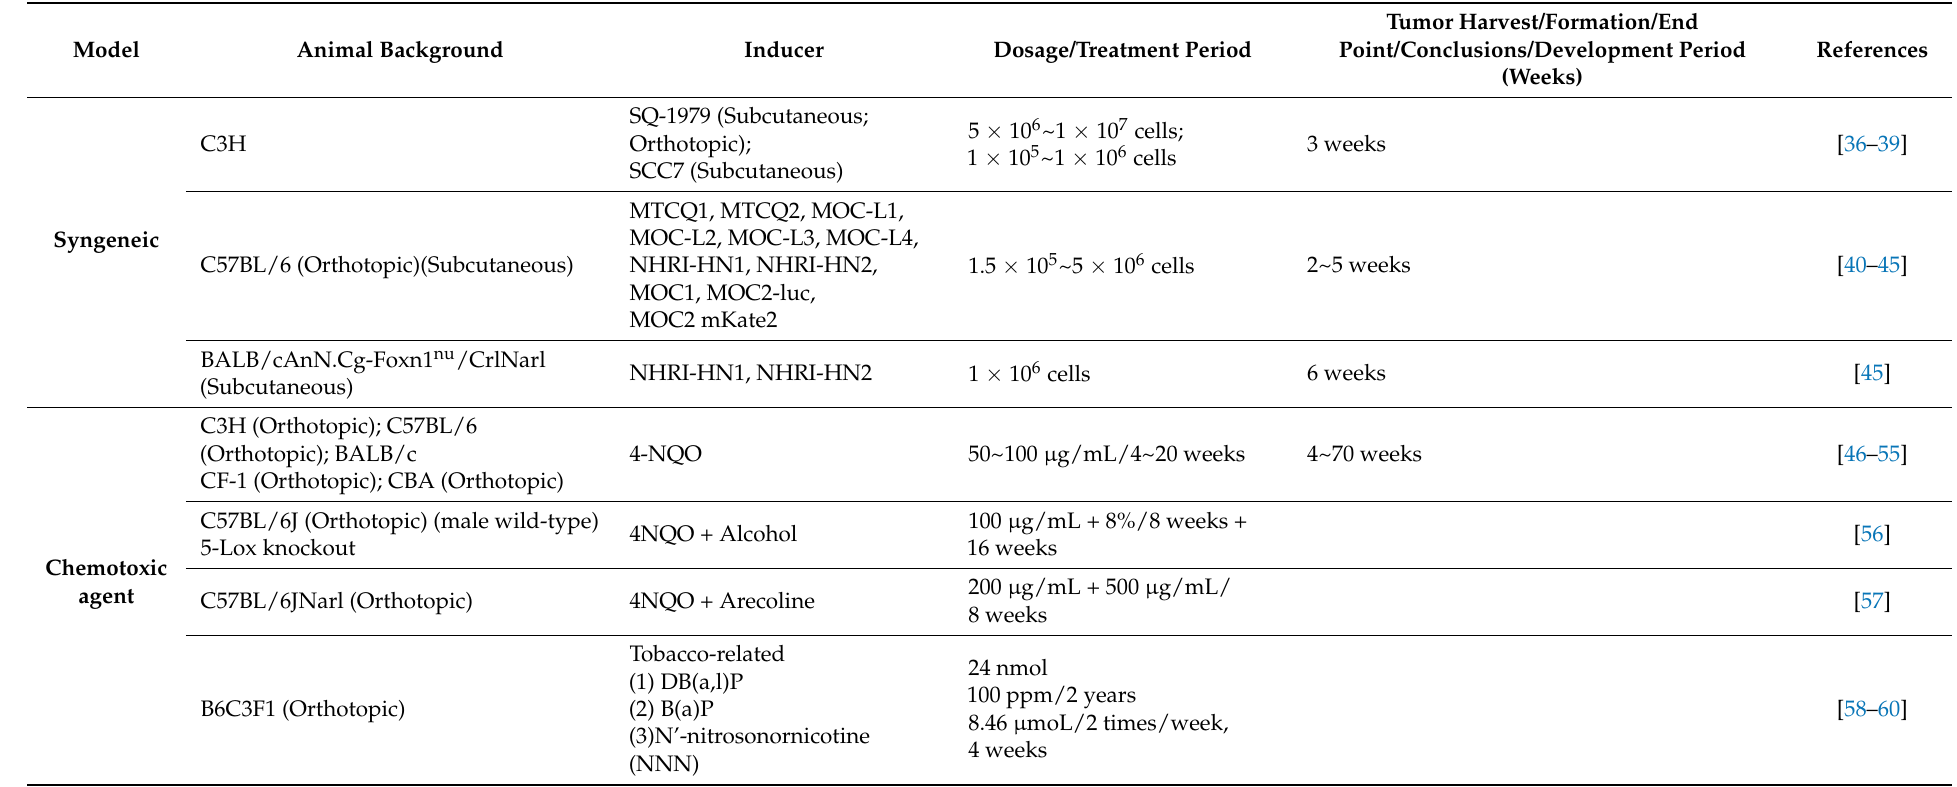
Table 3. Mouse models used for immunotherapy in oral